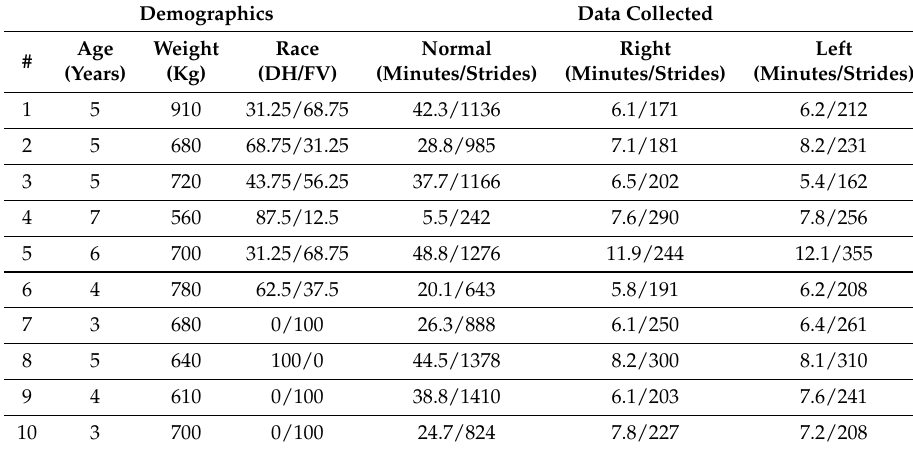
Table 1. Demographic data of the cows that took part in the controlled experiment and statistical information about the data we collected. GH = German Holstein, FV =